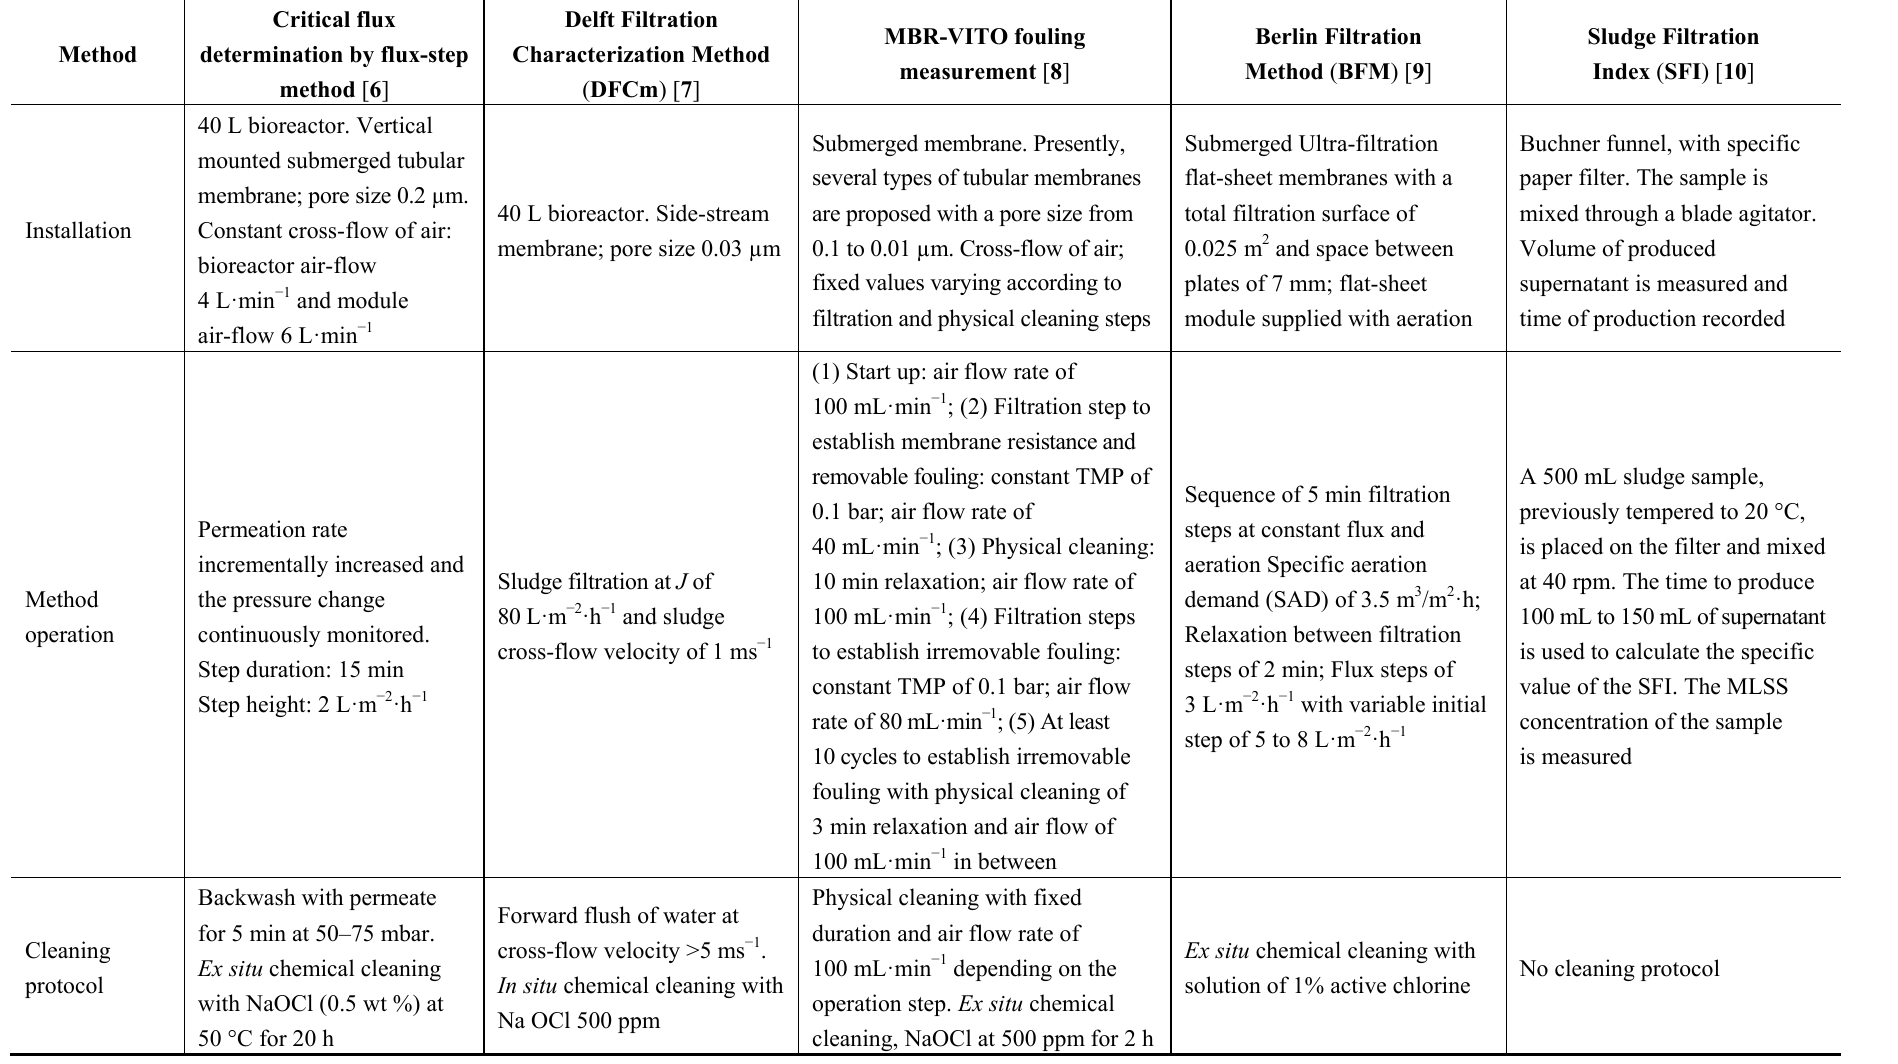
Table 2. Installation/operation of methods to qualify/quantify the fouling potential in